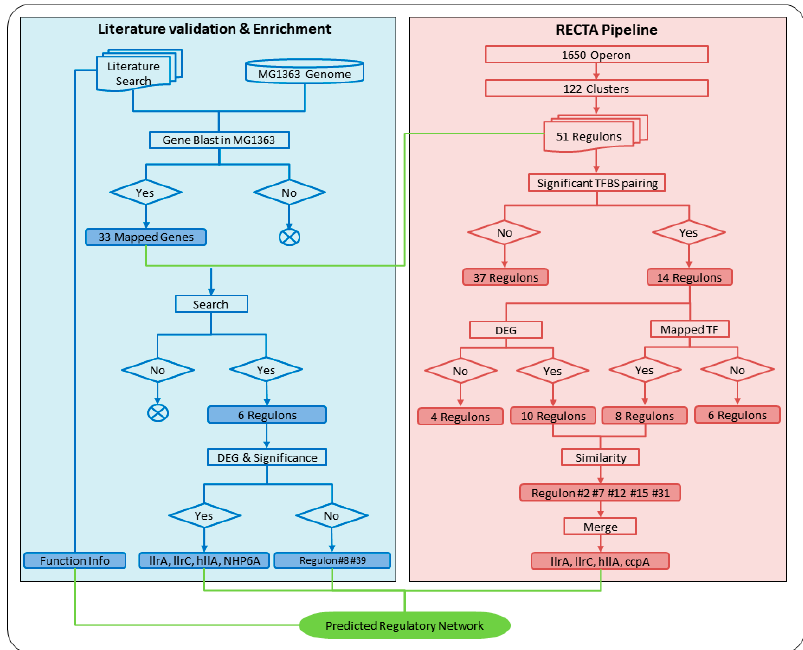
Figure 2. Regulon prediction using regulon identification based on comparative genomics and transcriptomics analysis (RECTA) pipeline (red) and validation and enrichment using literature information and gene blast (blue). All processes were shown in rectangles and results were highlighted with corresponding background colors. In the computational pipeline, 51 regulons with assigned motifs and operons were analyzed sequentially through significant TFBS pairing, DEG conformation, and TF BLAST. Only regulons contained DEGs (10) which had related mapped TF (8) were believed to be the final predicted ASR-related regulons (5). These five regulons were then merged into four, using the corresponding TFs to represent their names. In the literature validation process, known ASR-related transporters were first mapped to the MG1363 genome and resulted in 33 genes. Those genes were then searched in 51 regulons and determined six related regulons. All regulons resulting from both computational pipeline and literature validation were combined, along with the information of functional modules, to determine the